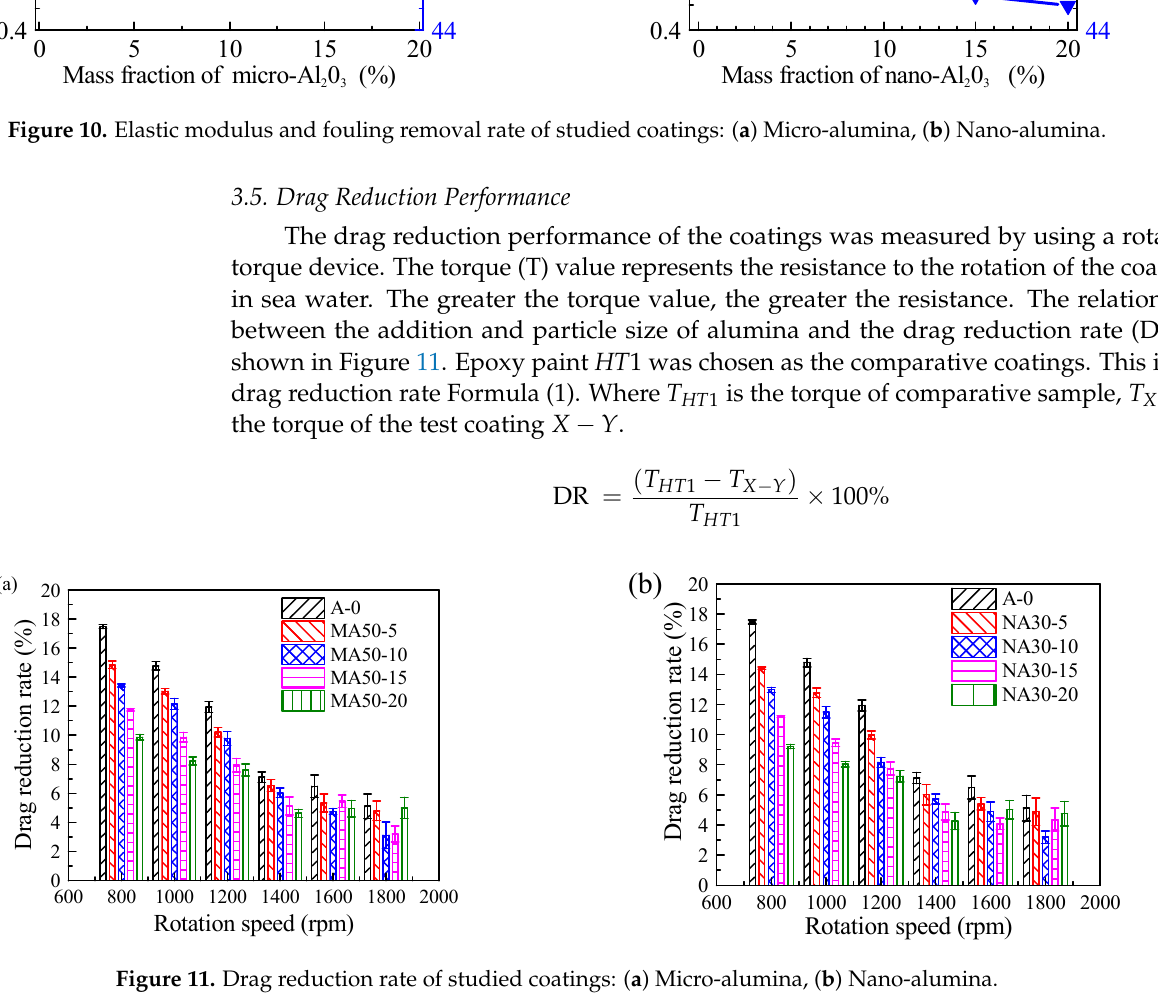
Figure 11. Drag reduction rate of studied coatings: ( a ) Micro-alumina, ( b ) Nano-alumina. In Figure 11, under the condition of 800–1400 rpm, the increase of alumina content and the decrease of particle size will decrease the drag reduction performance of the coat- ings. Some studies have shown that flexible materials have an obvious drag reduction effect, because the elastic modulus of the material is low, which can release friction re- sistance through surface deformation [34,35]. In the alumina reinforced PSO/PDMS coat-